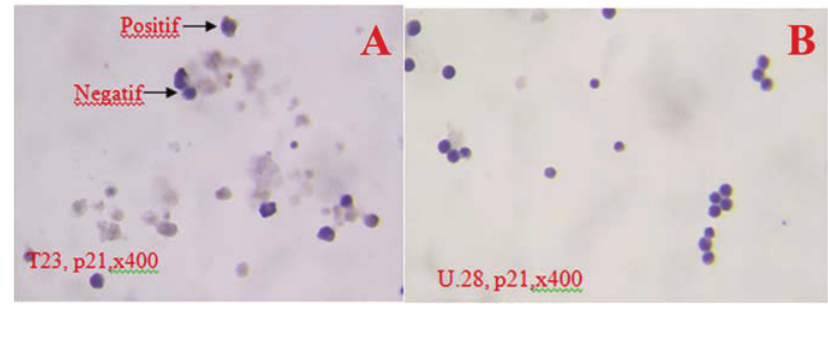
Figure 4. p21 Expressions by Immunohistochemistry from (a) treatment group and (b) control